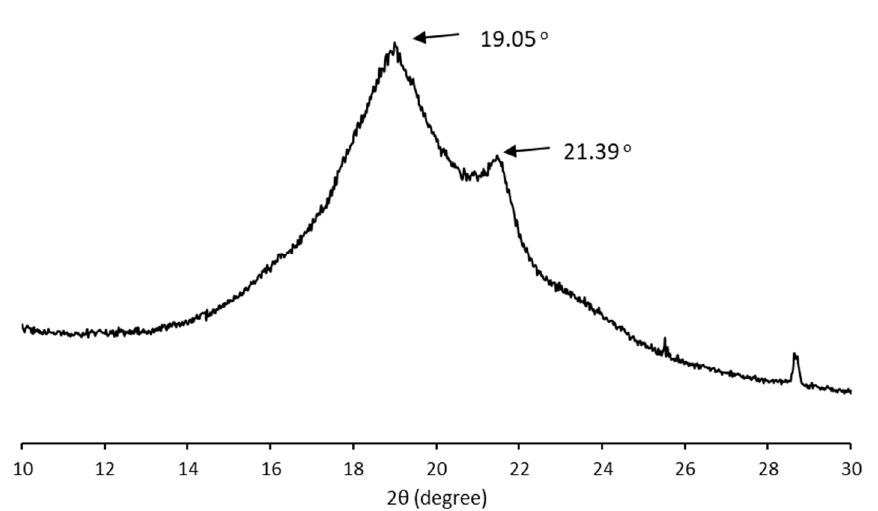
Figure 7. X-ray diffraction pattern of MCL-PHA terpolyester sample. Table 2. Physical properties of MCL-PHA terpolyester sample.